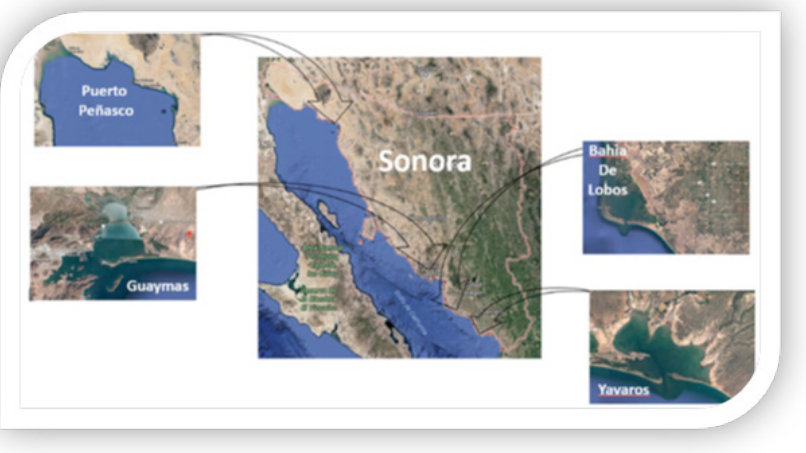
Figure 1: a) Map of Sonora State showing the location of the sampled sites: Puerto Peñasco, Guaymas, Bahia de Lobos and Yavaros (Fuente: Imágenes ©2016 Landsat, Data SIO, NOAA, U.S. Navy, NGA, GEBCO, Data LDEO-Columbia. NSF, NOAA, Datos del mapa ©2016 Google,